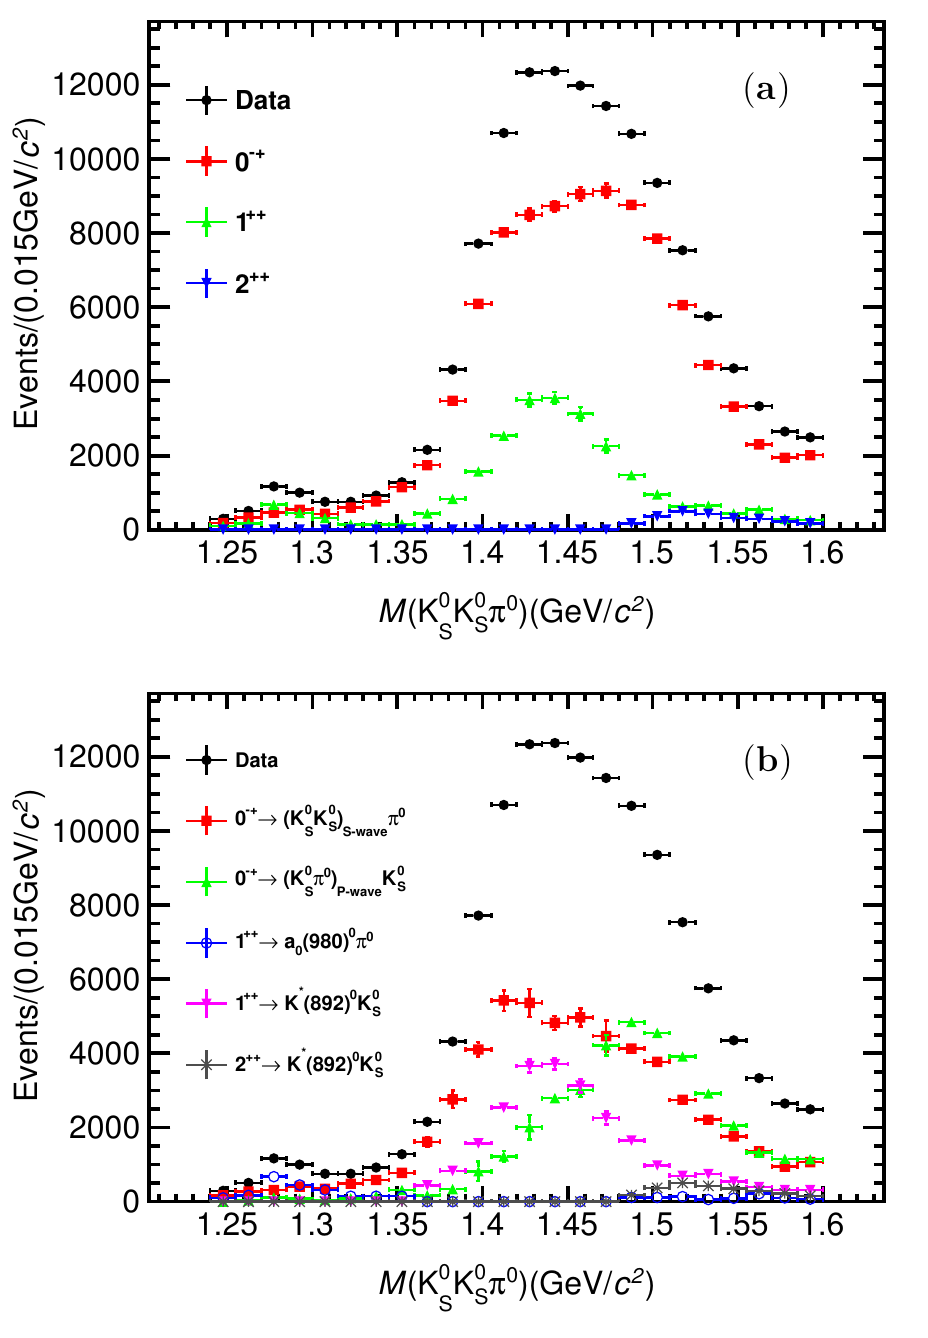
Figure 3 . The K 0 K 0 π 0 intensity spectra for the (a) dominant spin-parity components and (b) S S dominant decay modes for different spin-parity components obtained from the MI PWA results. The uncertainty on the total data is statistical, and the uncertainties on the others are obtained from the PWA in each